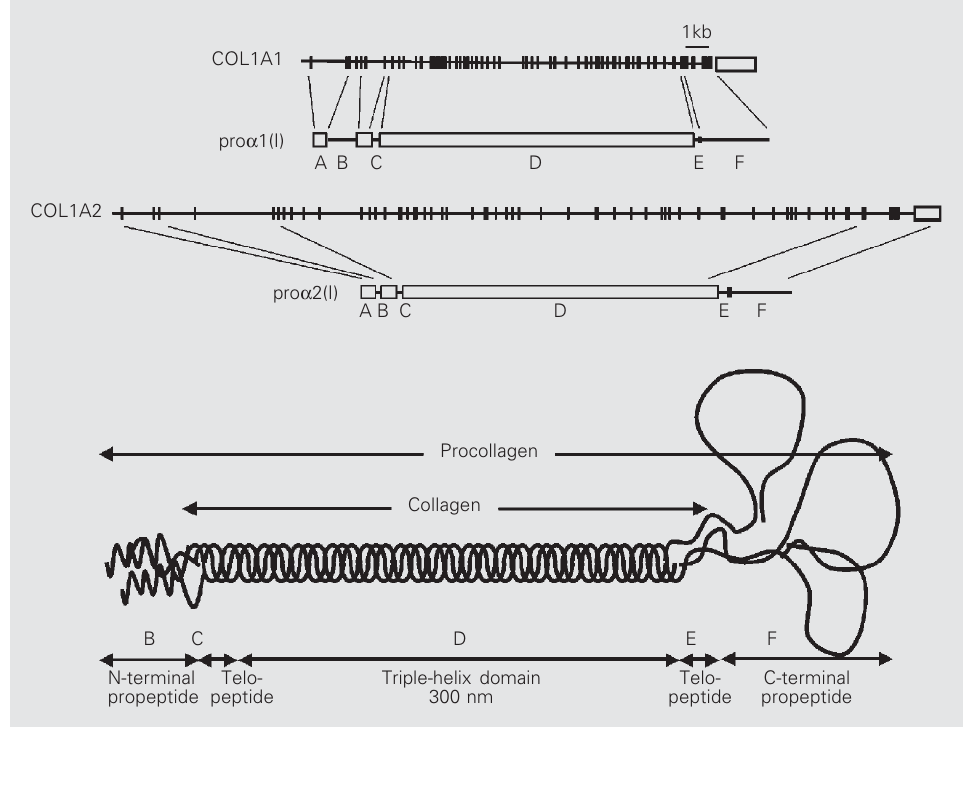
Figure 3. Biosynthesis of fibrillar collagens. Modifications of the procollagen peptide in the rough endoplasmic reticulum (RER) in- clude hydroxylation, glycosyla- tion, and disulfide bond forma- tion. Interchain disulfide bonds between the C-terminal pep- tides align the three chains and initiate formation of the triple helix. The process propagates towards the N-terminus of the molecule end. N-linked oligosac- charides are transferred to the propeptides in the RER and pro- cessed in the Golgi apparatus. Upon secretion, propeptides are cleaved, allowing lateral align- ment and crosslinking. See text for